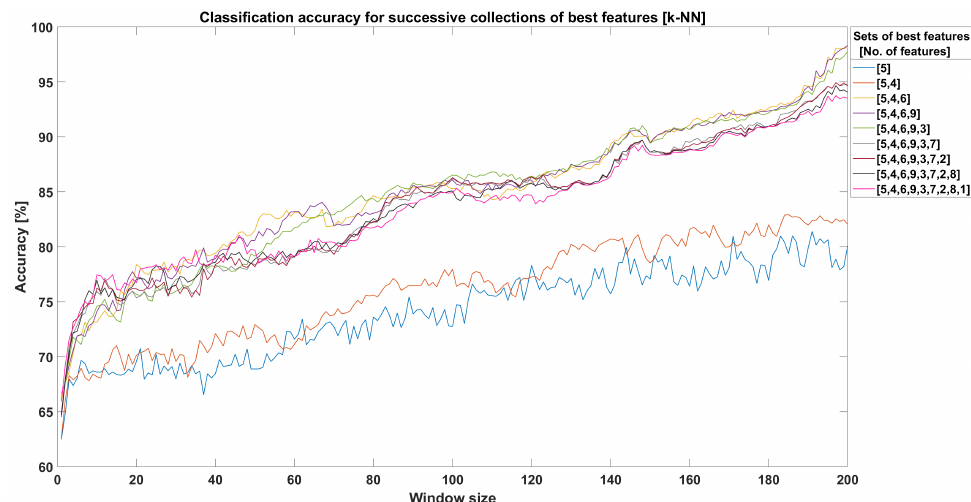
Figure 9. Classification accuracy for successive collections of best features [k-NN].